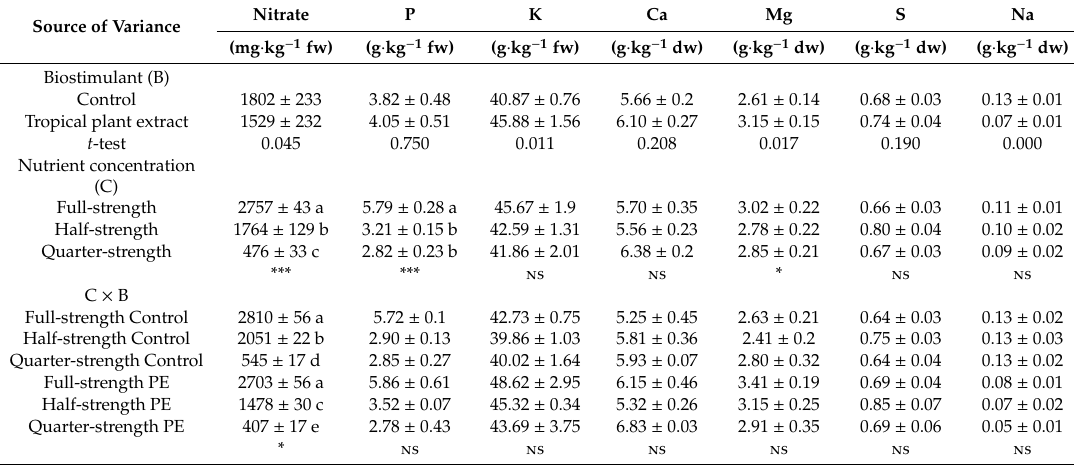
Table 2. Nitrate, phosphorus (P), potassium (K), calcium (Ca), magnesium (Mg), sulfur (S), and sodium (Na) concentrations of hydroponically grown jute in relation to nutrient solution concentration and tropical plant extract biostimulant application. All data are expressed as mean ± error, n = 3. Source of Variance